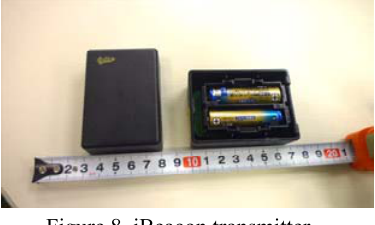
Figure 8. iBeacon transmitter